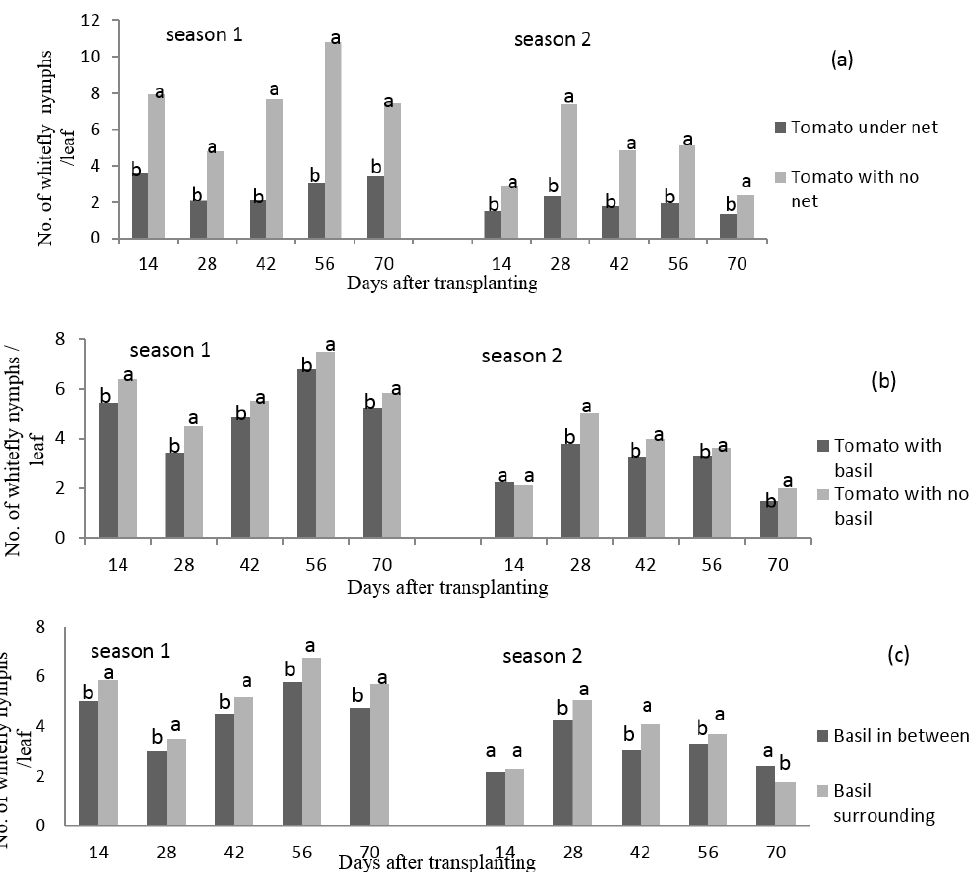
Figure 2. Effects of agronet cover,( a ) companion planting,and ( b ) planting design ( c ) on No. of B. tabaci nymphs/leaf on tomato plants during tomato production in season 1 (December